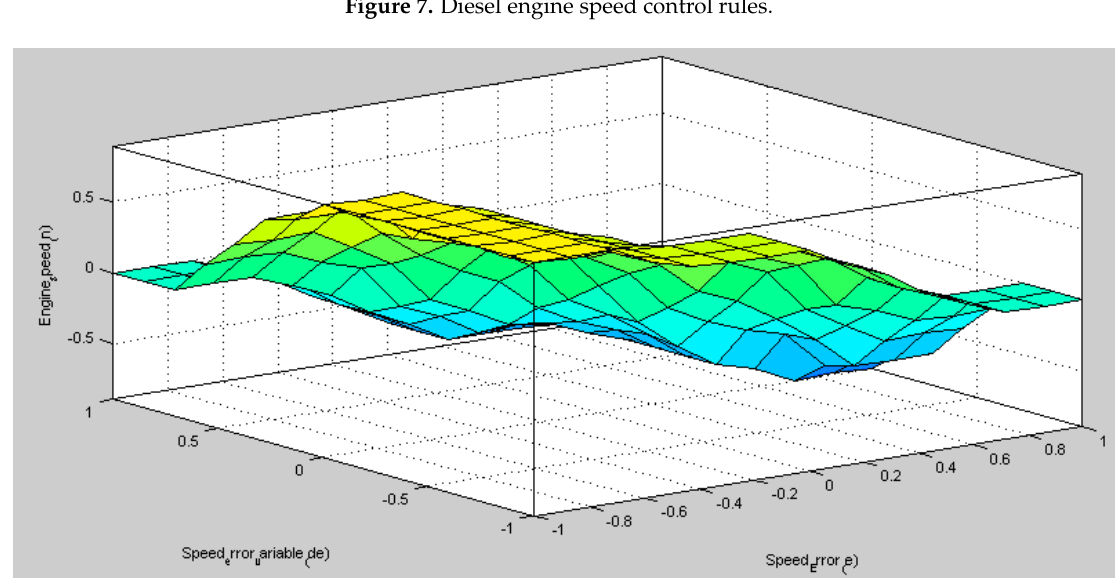
Figure 8. Surface of diesel engine speed control.3.2. Optimization of Main Diesel Engine Rotational Speed Control Process by Particle Swarm Optimization Algorithm.